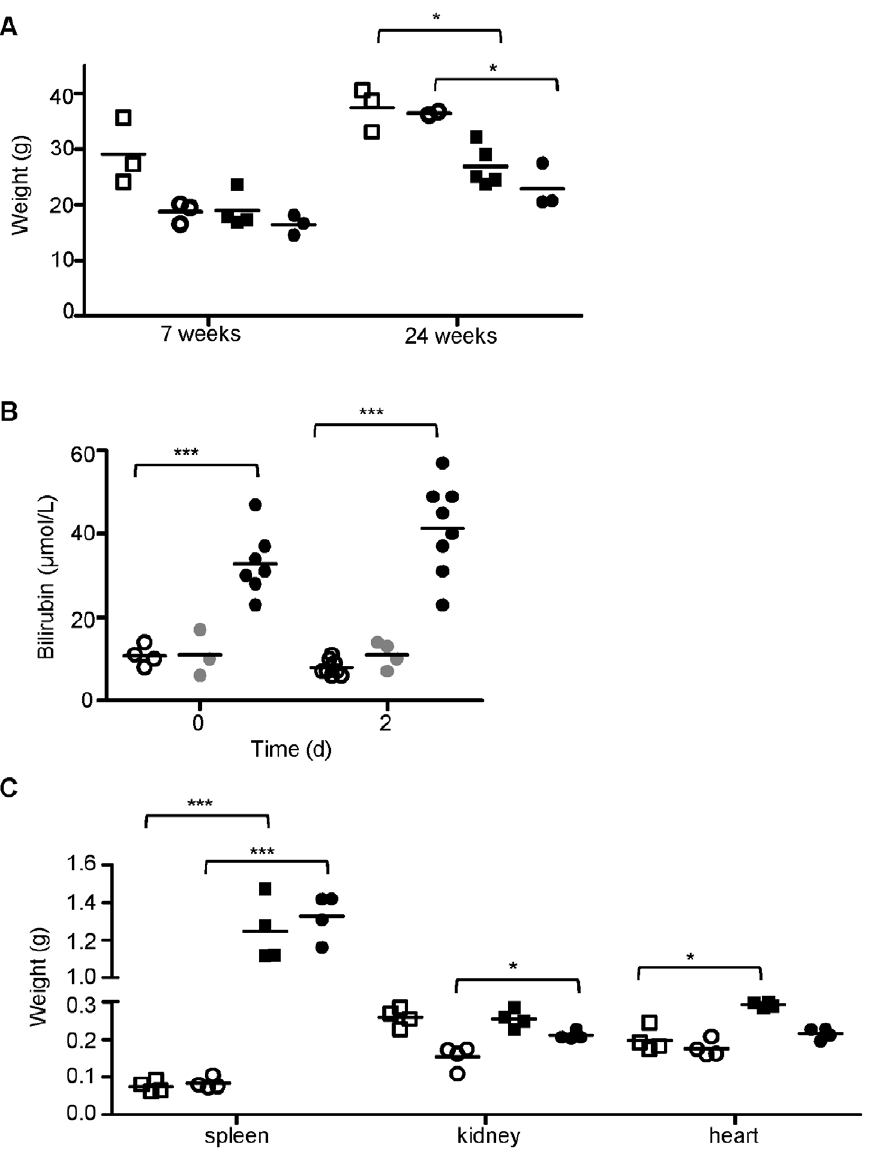
Figure 2. Ity16 mutant mice present massive splenomegaly, moderate increase in kidneys and heart weights and bilirubinemia. A) Body weight of wild type littermates and Ity16 mice by sex (males are represented by squares, females by circles) at 7 weeks (open and black fill) and 24 weeks (open and black fill) n=3 per sex and genotype. B) Serum bilirubin levels were measured at day 0 and day 2 post infection in wild type (open circle), heterozygous (gray circle) and Ity16 mutant (black circle) mice. C) Increased spleen, kidney and heart weights in Ity16 mutant (black fill) mice compared to wild type littermates (open fill). The data are presented by sex (males are squares, females are circles). Results are representative of at least two experiments. An * represents a P-value of less than 0.05; ** represents a P-value of less than 0.001; *** represents a P-value of less than 0.0001.